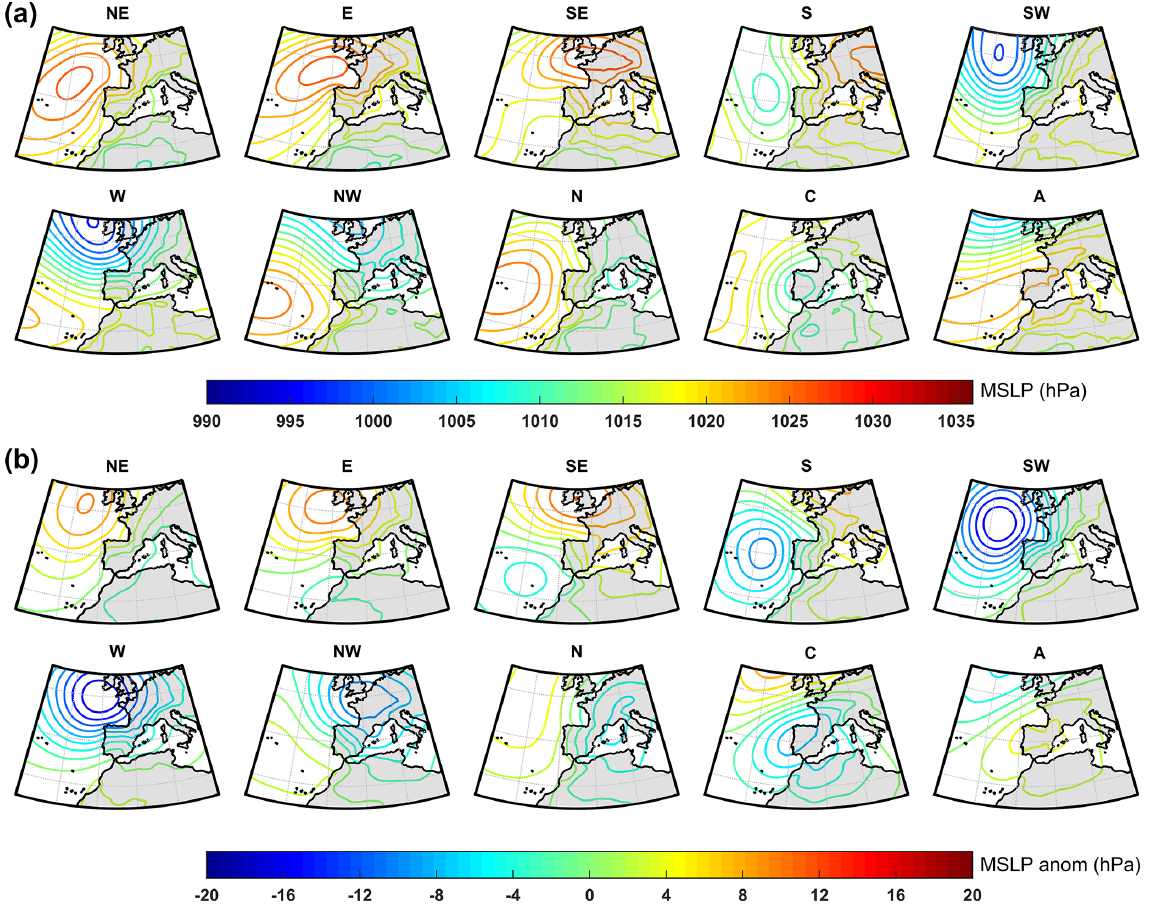
Figure 8. (a) Mean sea level pressure (MSLP) fields and (b) anomaly (anom) field configuration of the 10 pure circulation weather types (CWTs) for the period of 1980–2017. The contour interval is